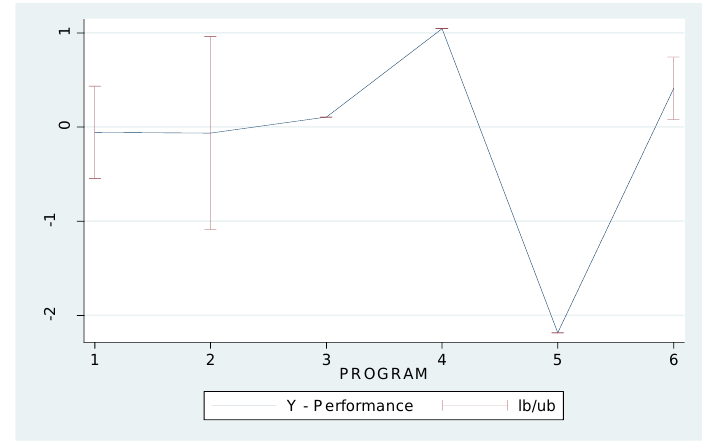
Figure 2: Confidence Interval (CI) plots (Heterogeneity of Performance)